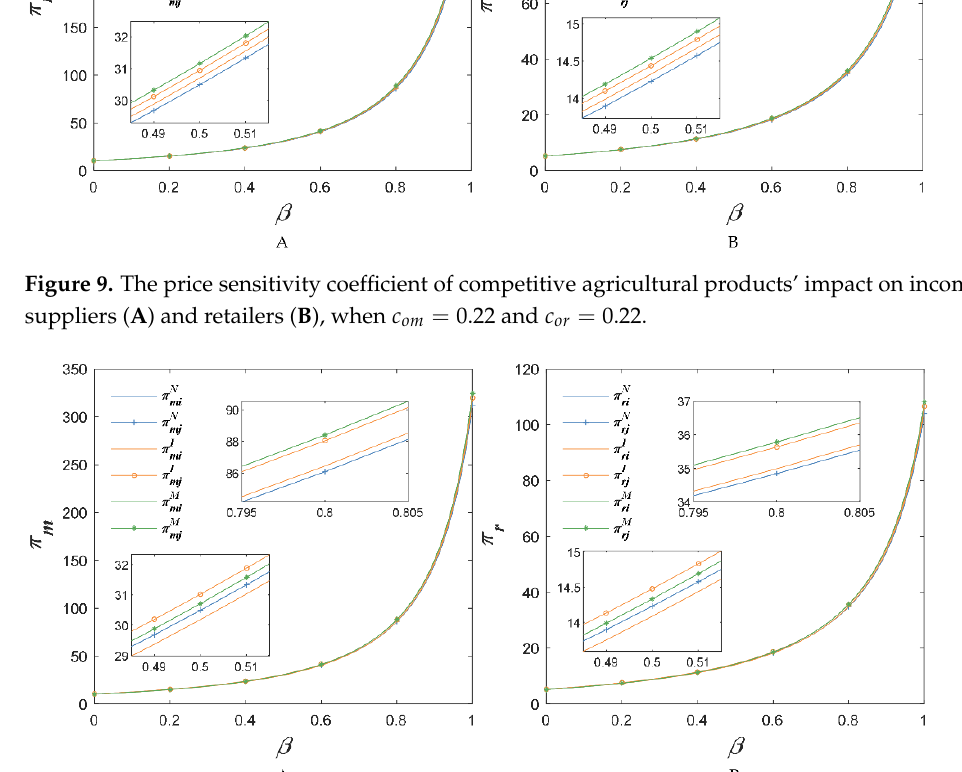
Figure 10. The price sensitivity coefficient of competitive agricultural products’ impact on income of suppliers ( A ) and retailers ( B ), when c om = 0.29 and c or = 0.29 .